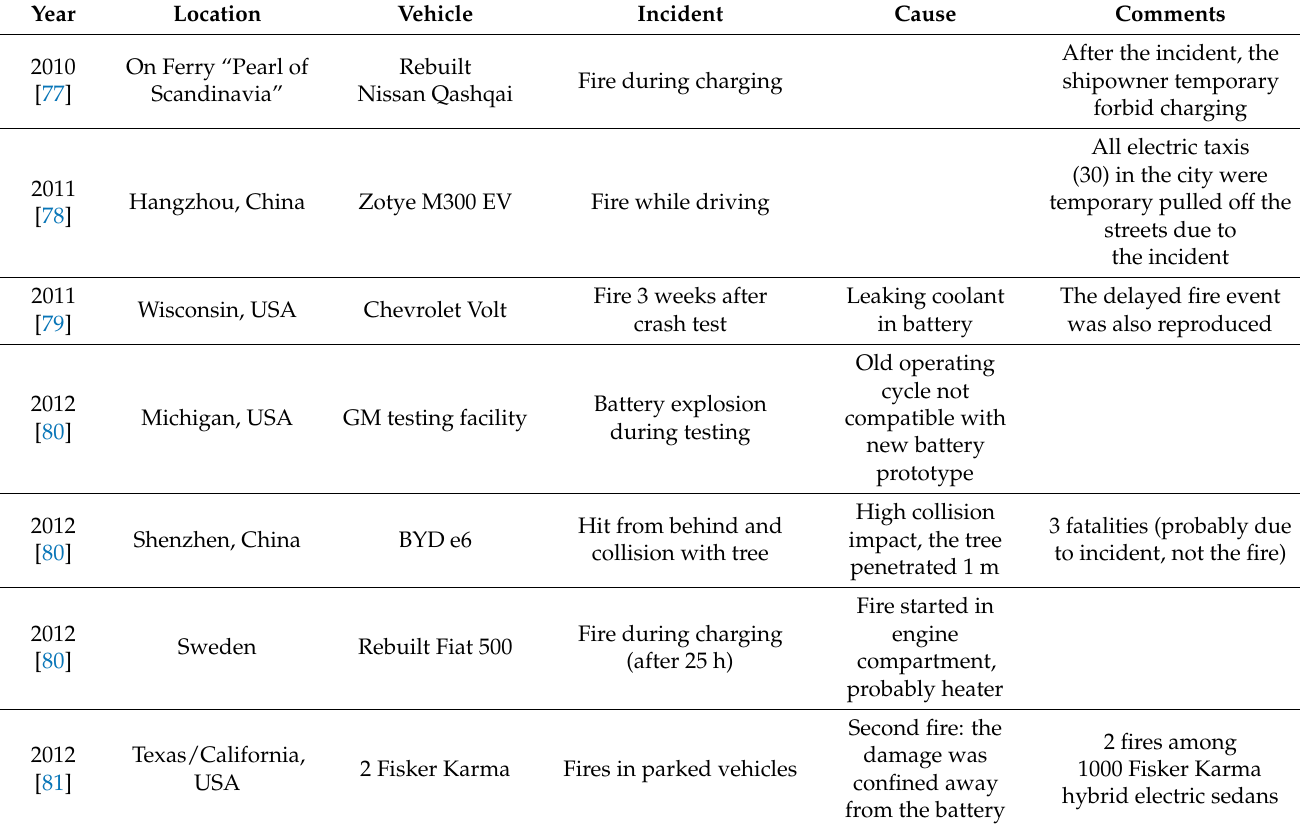
Table 2. Summary of electric vehicle fire attacks in a decade.